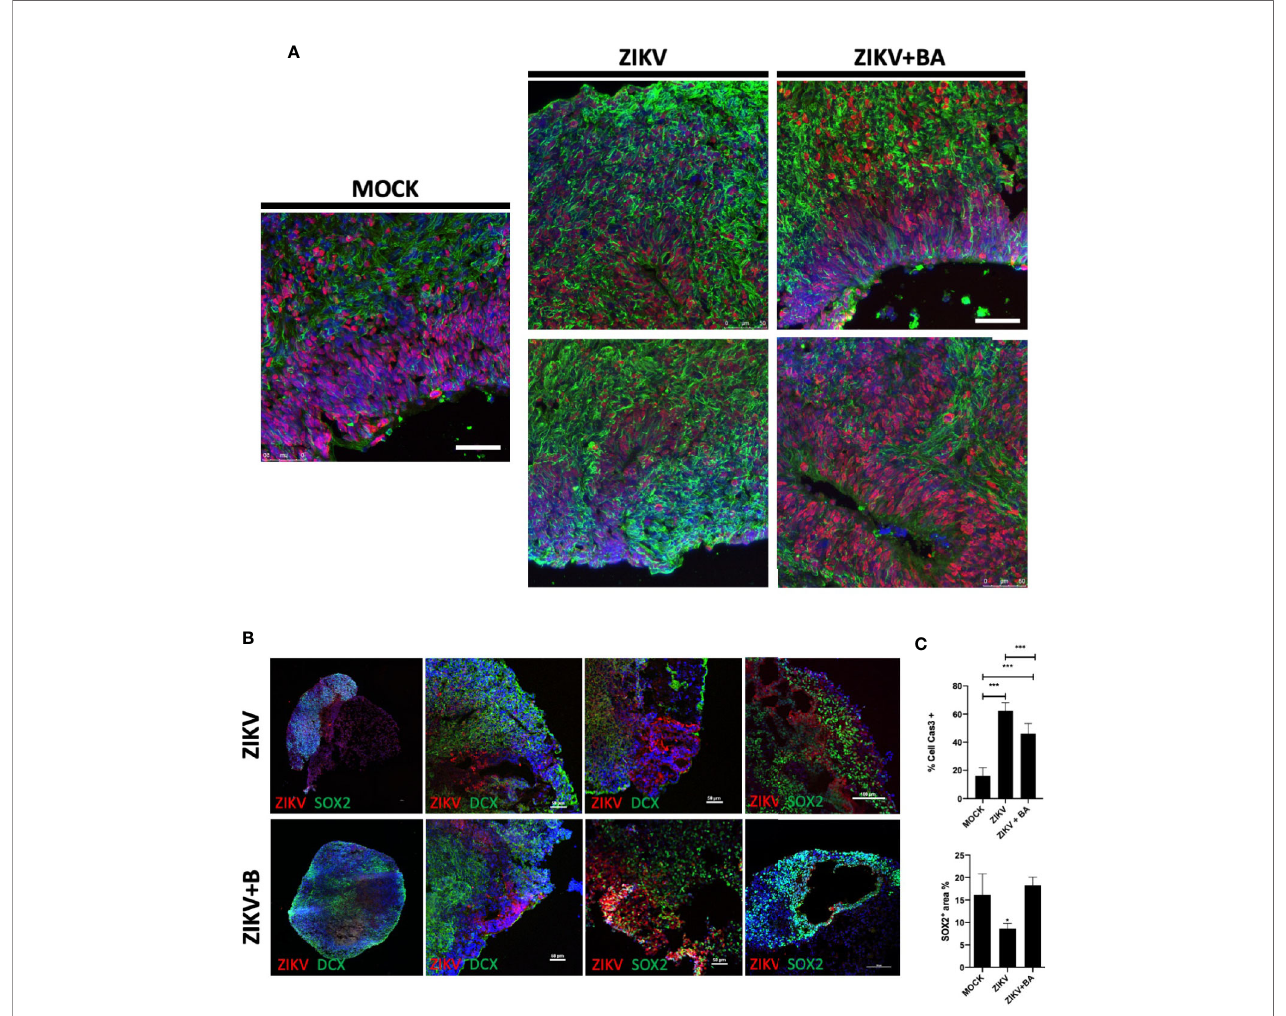
FIGURE 4 | Betulinic acid treatment in Zika virus (ZIKV)-infected 6-week cerebral organoids. (A) Representative confocal microscopy images of histological sections obtained from cerebral organoids non-infected (MOCK), ZIKV-infected (ZIKV), or ZIKV-infected treated with betulinic acid at the concentration of 10 m M (ZIKV+BA) stained for SOX2 (red) and TUJ1 (green) neural progenitor cell (NPCs) and neuron markers, respectively, and nuclei counterstained with DAPI (blue). Scale bars = 50 µm . (B) Representative images of the organoids stained for ZIKV (red) and either SOX2 or DCX (green), as indicated. Scale bars = 50 µm . (C) Quanti fi cation of Casp3+ and SOX2 + cells in the cerebral organoids area after treatment with betulinic acid. Multiplicity of infection (MOI) of 1. * p < 0.05, ***p < 0.001. Values represent the mean ± SEM of three